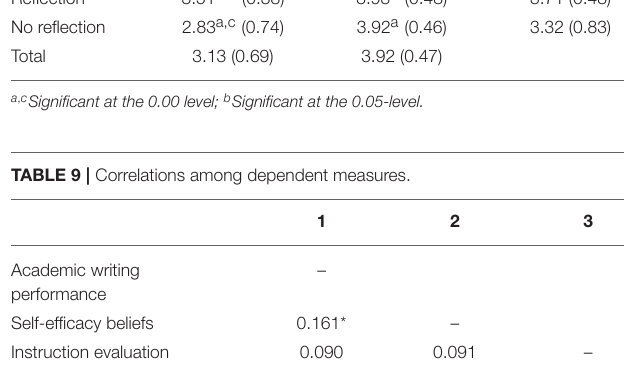
TABLE 11 | Correlations among dependent measures in the reflection and no reflection